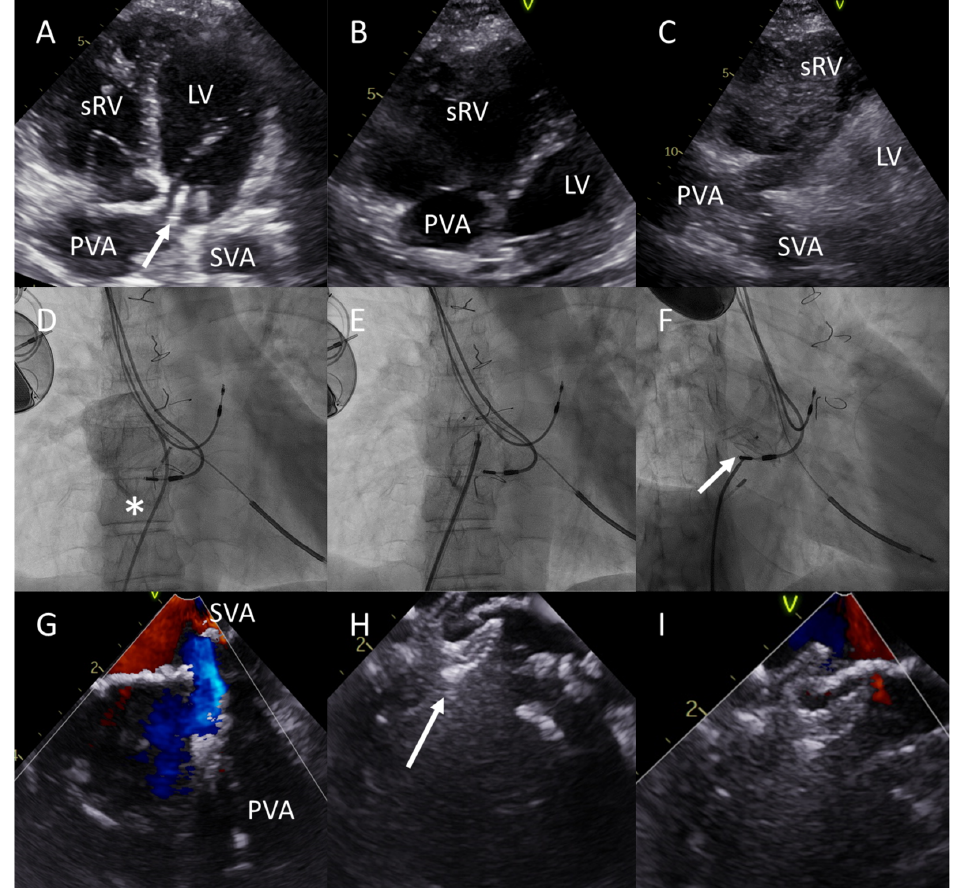
Figure 1. Baffle leak visualisation and closure in patient A. ( A , B ) Apical four chamber and subcostal views, respectively show the atrial baffle (arrow) that directs blood from the systemic venous atrium (SVA) to the subpulmonary left ventricle (LV) and from the pulmonary venous atrium (PVA) to the dilated systemic right ventricle (sRV). ( C ) Agitated saline contrast echocardiography confirms significant interatrial shunting from the SVA to the PVA during Valsalva, with bubbles filling the sRV cavity within 3 heart beats. ( D – F ) Anterior ‐ posterior ( D , E ) and right inferior oblique ( F ) fluoroscopy projections during intracardiac echocardiography (ICE, probe indicated with an asterisk (*) in ( D )) guided closure of the baffle leak with a 10 mm Amplatzer Septal Occluder (arrow in F ). Note the two atrial pacing wires and an implantable cardioverter ‐ defibrillator (ICD) lead in the LV. ( G – I ) ICE imaging during closure of the baffle leak. Note the shunting from the SVA to the PVA during Valsalva through the baffle defect ( G ), the discs of the Amplatzer Septal Occluder in situ ( H , arrow) and the alleviation of the interatrial shunt ( I ).